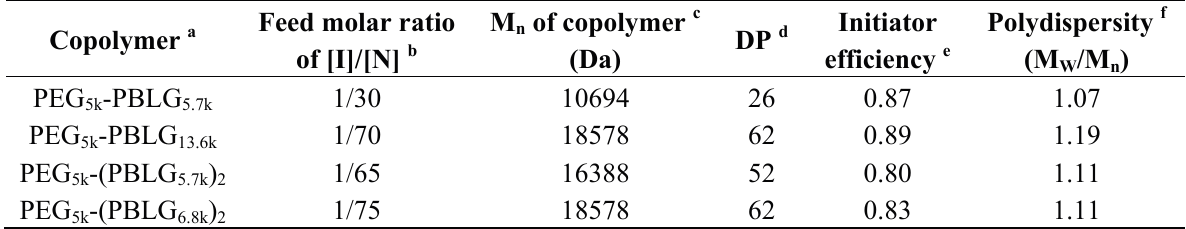
Table 1. Compositions and some characteristic properties of hybrid polypeptide